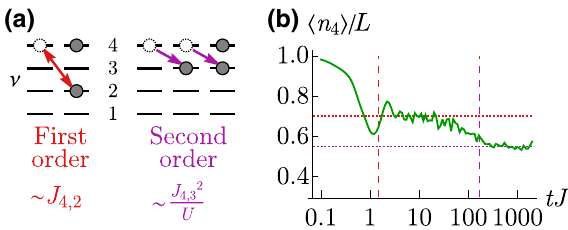
FIG. 9. (a) Dominant resonant processes for an n = 4 system at the (cid:2) = U / 2 resonance for our initial state with all atoms in the highest-energy dressed state ν = 4. The typical rates for each process are shown. Other processes with similar rates can also occur, although they require additional moves to become allowed starting from this initial state. (b) Time evolution of the dressed state population. System size is L = 7, parameters are U / J = 30, (cid:2)/ J = 15, φ = 2.0. The system first saturates to an average of approximately 0.7 (dotted red line to guide the eye; not a the- ory prediction), which is close to the prediction of 2 first-order resonant process. At later times there is a further satu- ration to a different average of approximately 0.54 (dotted purple line to guide the eye). The associated timescales t | J 4,2 | = 1 and t | J 4,3 | 2 / U = 1 are shown by the dashed red and purple lines,